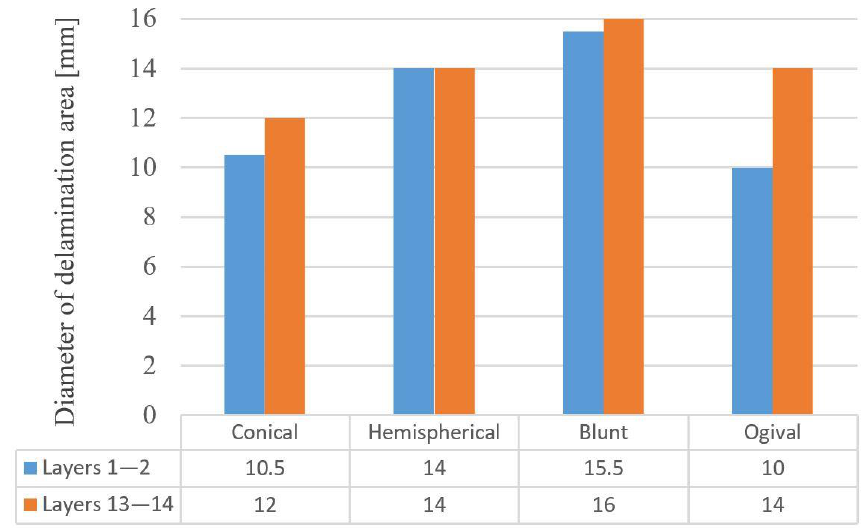
Figure 16. Diameters of delamination areas between reinforcement layers 1 and 2 and 13 and 14.